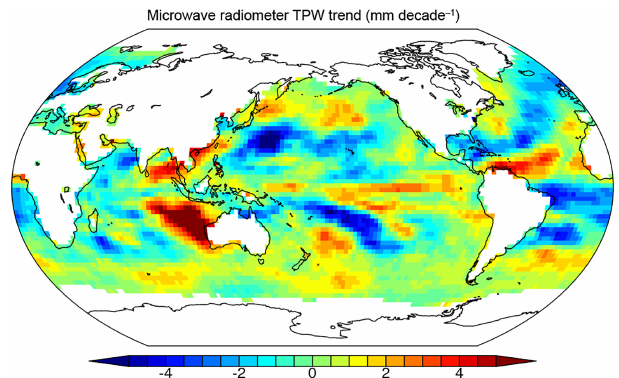
Figure 10. The global map of TPW trend in millimeters per decade over oceans using all F16, F17, and WindSat data from 2006 to